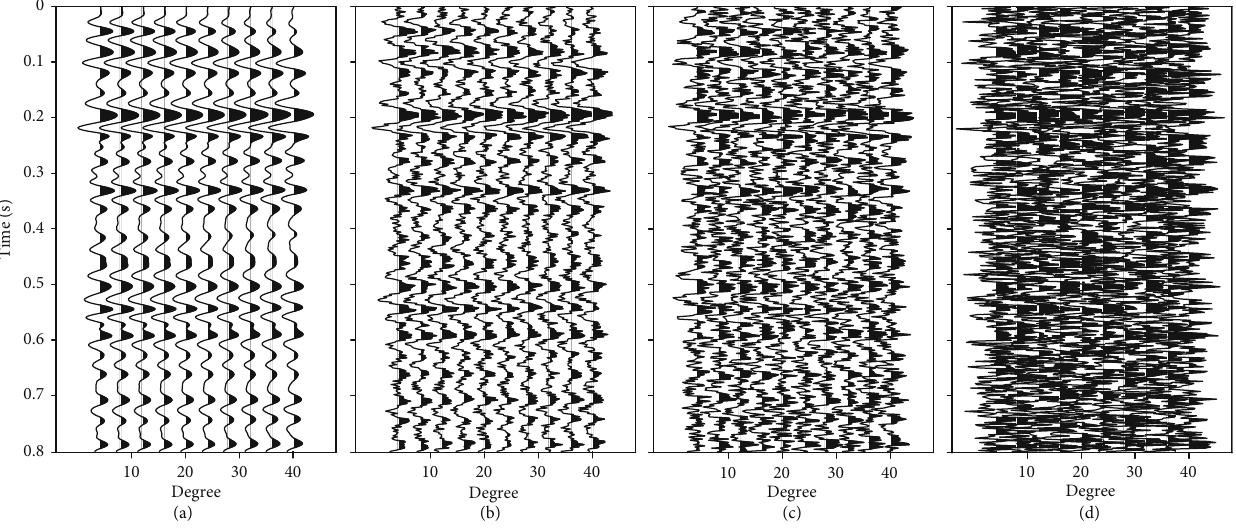
Figure 4: Synthetic prestack angle gathers: (a) noise-free, (b) SNR = 2 , (c) SNR = 1 , and (d) SNR = 0 : 5